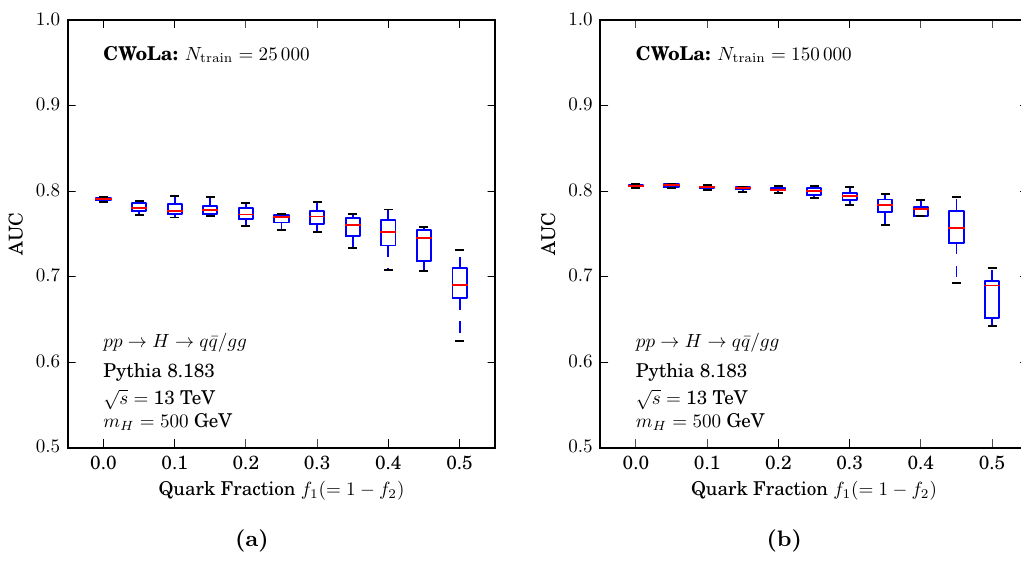
Figure 4 . Training performance of the CWoLa method on two mixed samples with f quark fraction. Shown are the range of AUC values obtained from 10 repetitions of training the neural network on (a) 25k events and (b) 150k events for 10